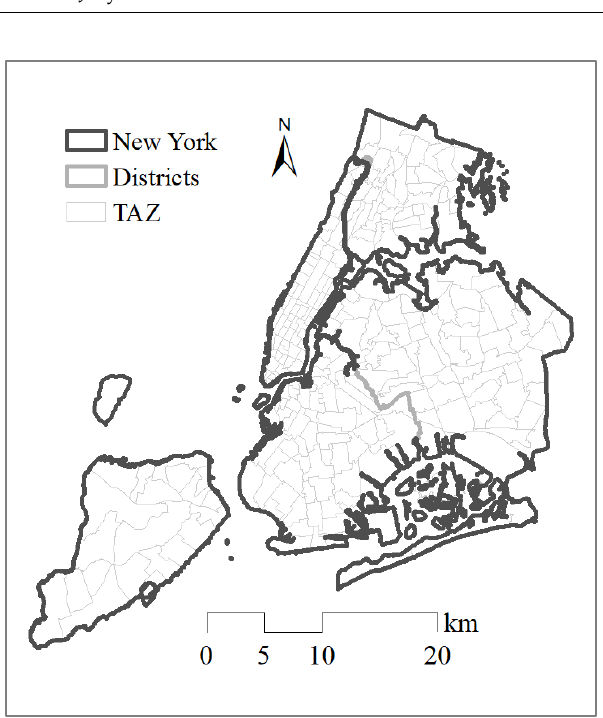
Figure 4. TAZs in New York.